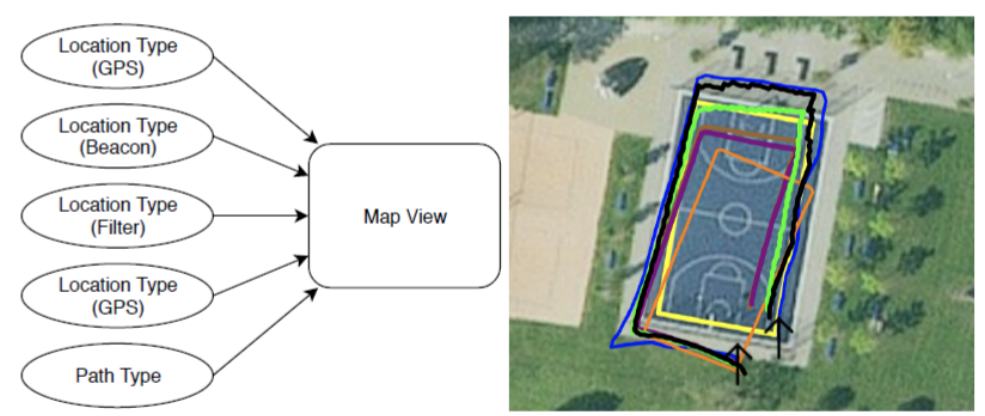
Figure 9. Overview of the map view data flow ( left ); example map view ( right ).